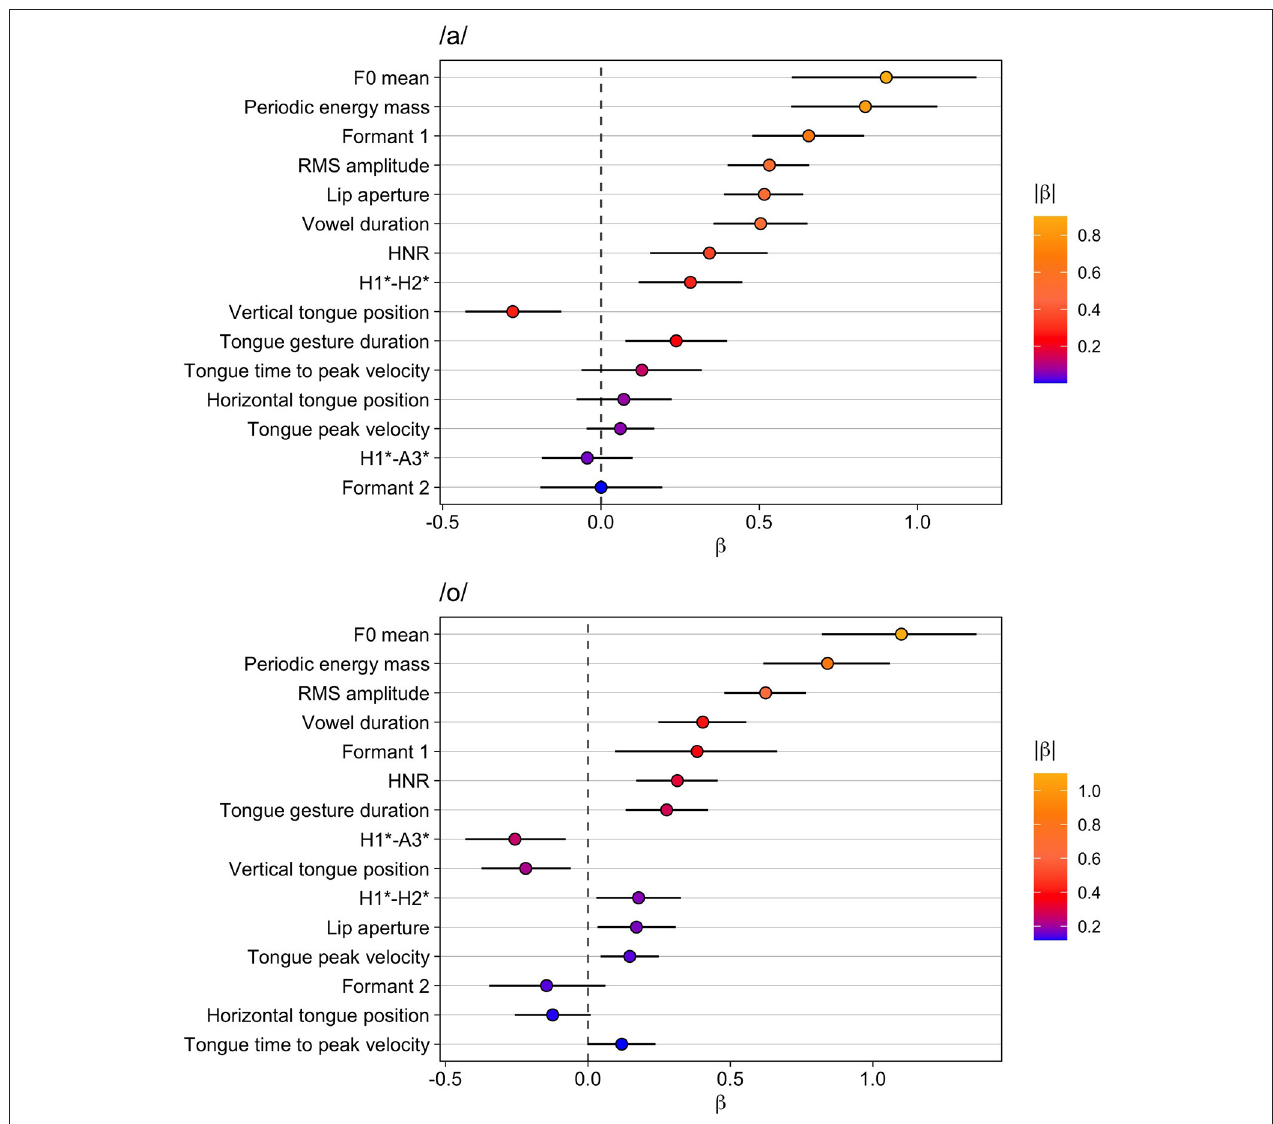
FIGURE 2 | Modeling results for unaccented vs. accented. Top: vowel /a/, bottom: vowel /o/. The whiskers indicate the 90% Credible